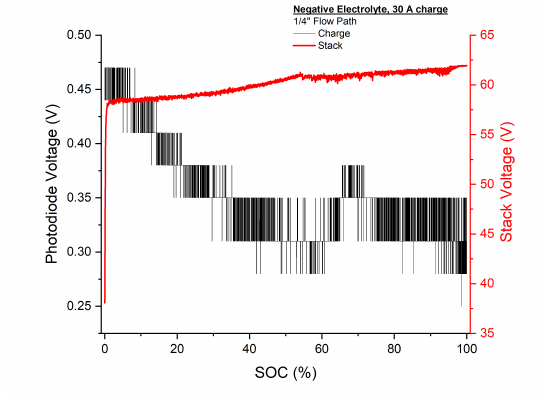
Figure 8. Negative electrolyte absorbance test utilizing a 1/4 (cid:48)(cid:48) flow cell (30 A charge)